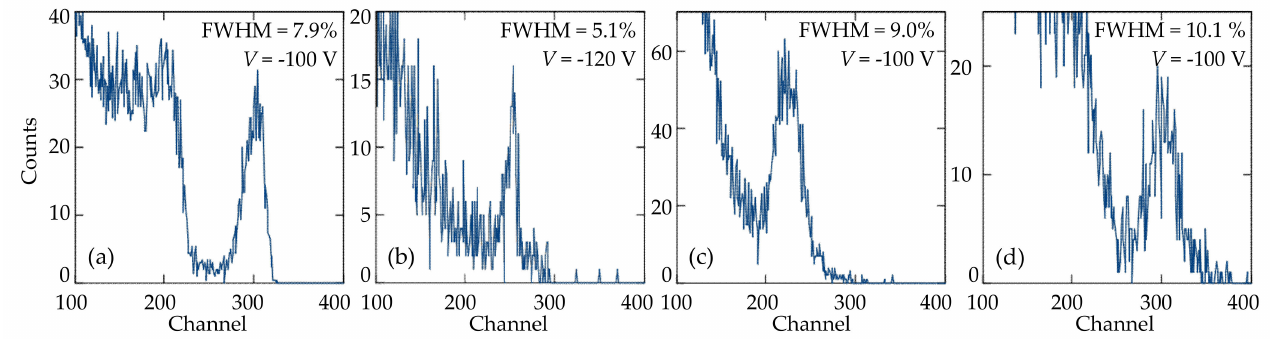
Figure 10. Room temperature spectra of a 137 Cs (662 keV) isotope taken with the ( a ) Mo-MoO x / p -CdTe/MoO x -Mo, ( b ) In/ p -CdTe/MoO x -Mo, ( c ) Ti-TiO x / p -CdTe/MoO x -Mo, and ( d ) Ti-TiN/ p -CdTe/MoO x -Mo Schottky-diode